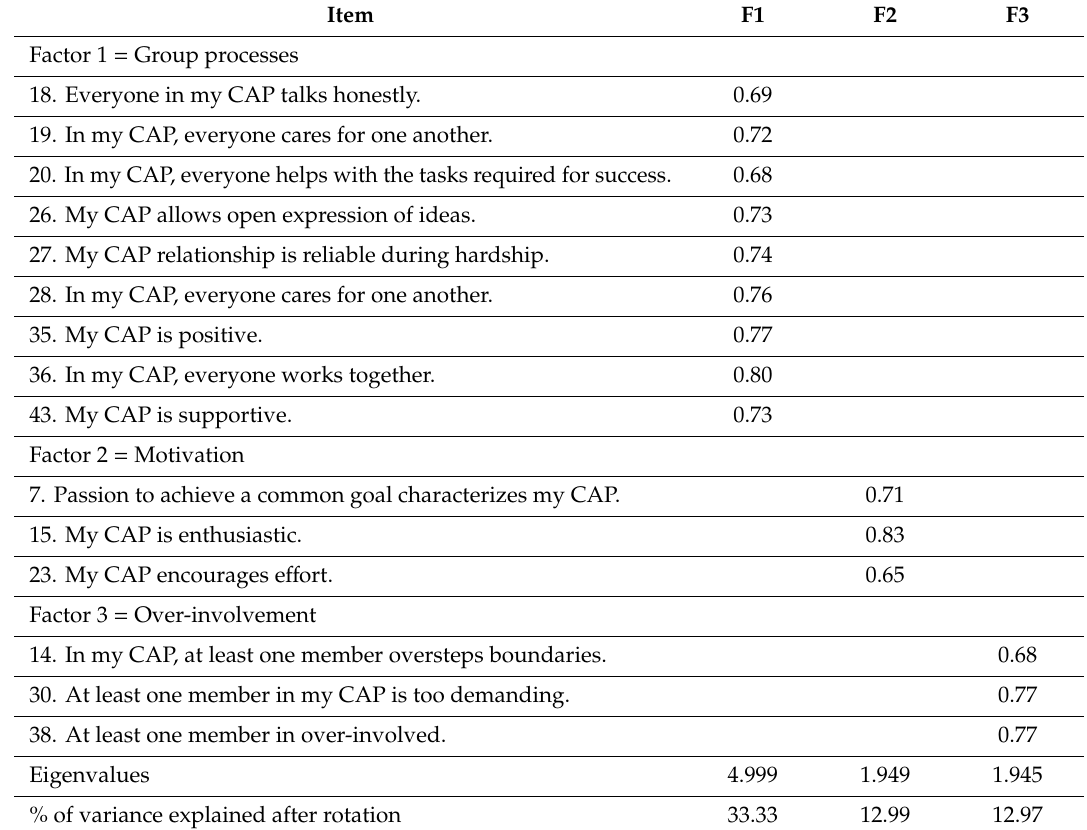
Table 1. Exploratory factor structure and